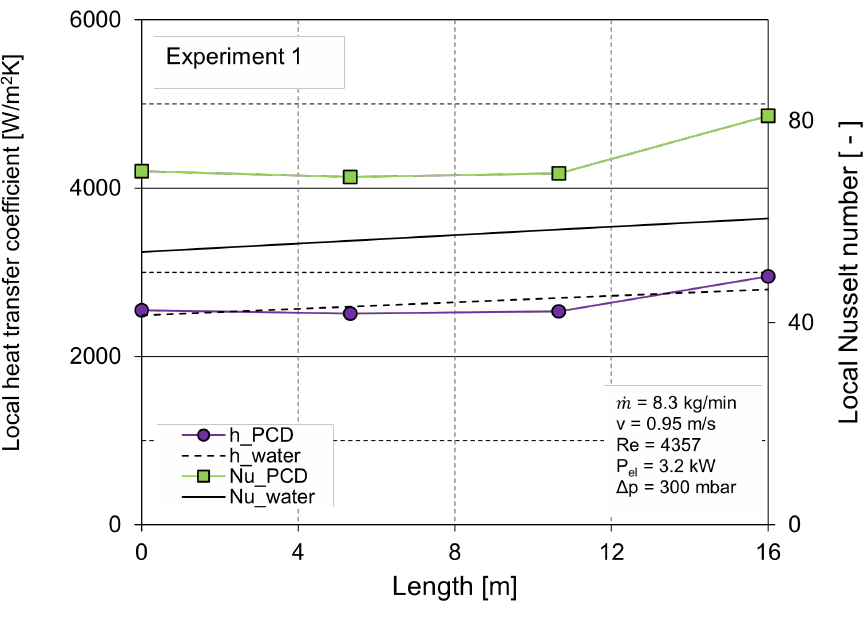
Figure 6. The local heat transfer coefficients and local Nusselt numbers for the PCD in experiment 1. Additionally, the local heat transfer coefficients and local Nusselt numbers for water at the same Reynolds number are